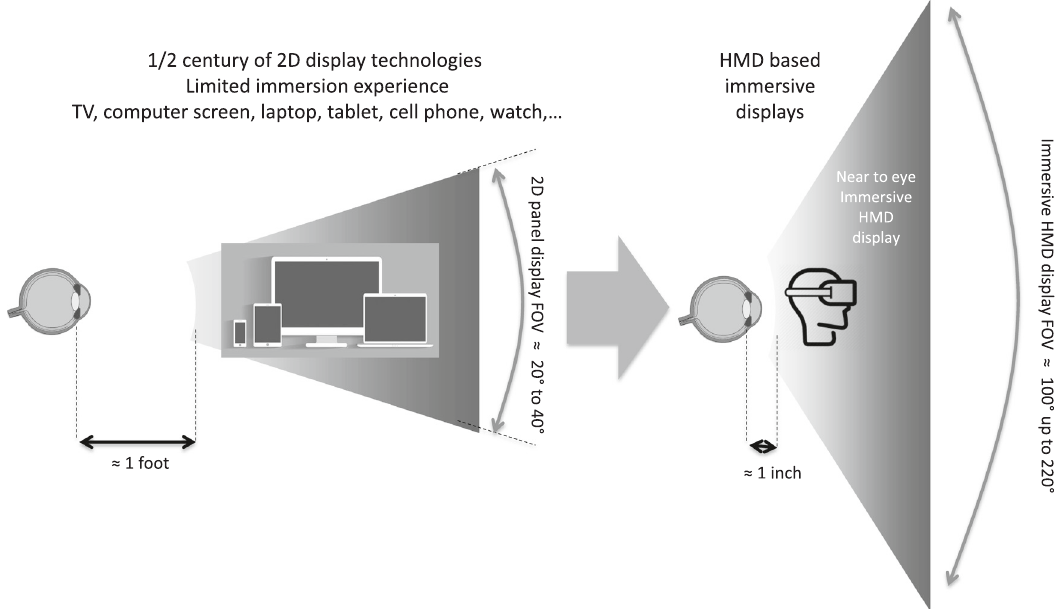
Figure 1: Immersive NTE displays: a paradigm shift in personal information display. NTE, near-to-eye.